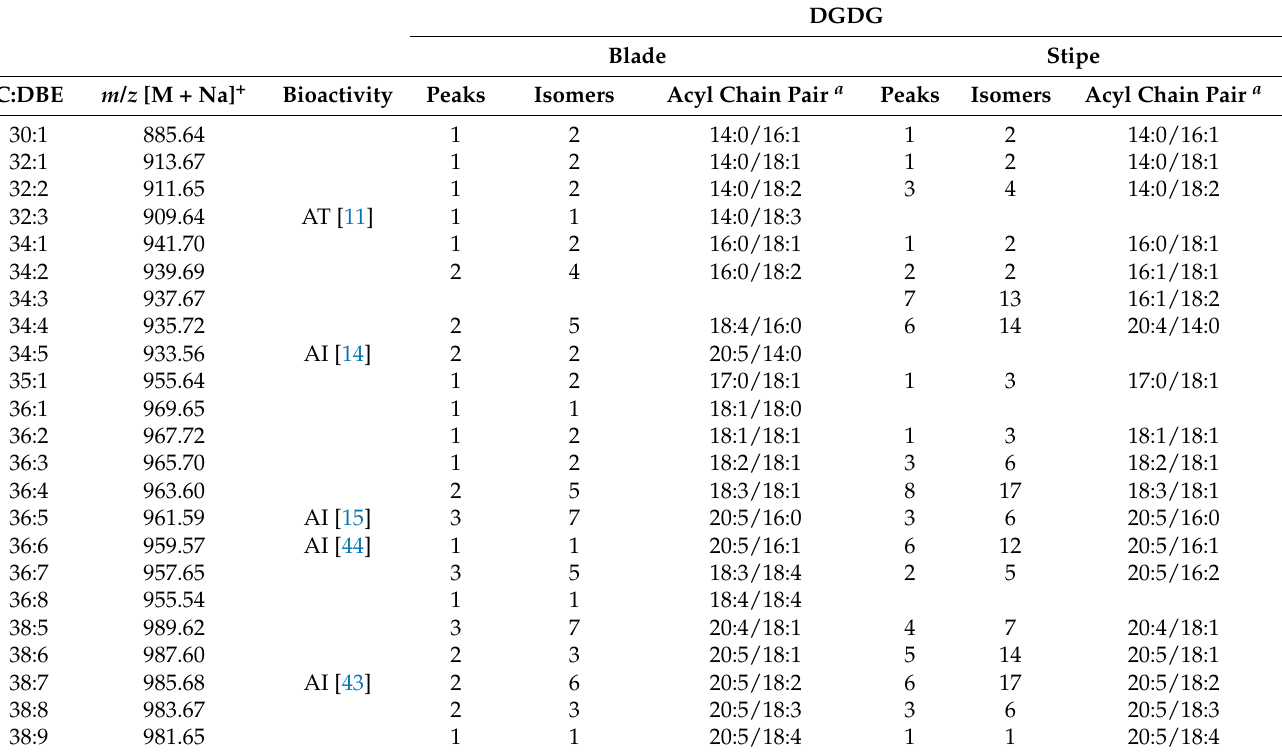
Table 2. Digalactosyldiacylglycerol (DGDG) lipids identified in blade and stipe of Laminaria hyperborea . DGDG Blade